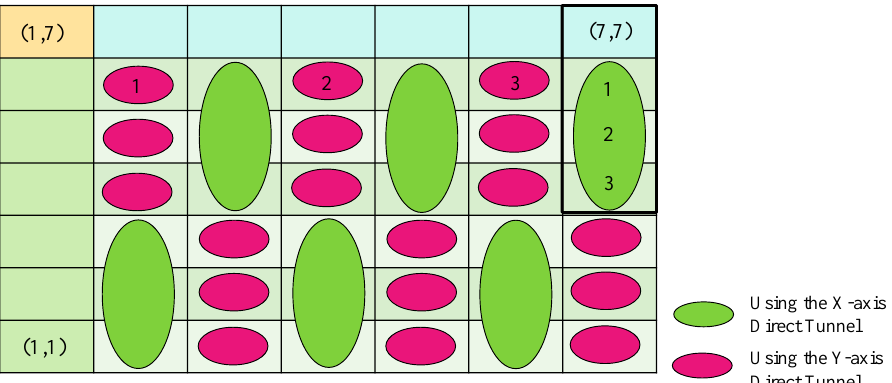
Figure 11. Tunnel assignment of a three-plane optical tunnel switching network with 49 nodes.